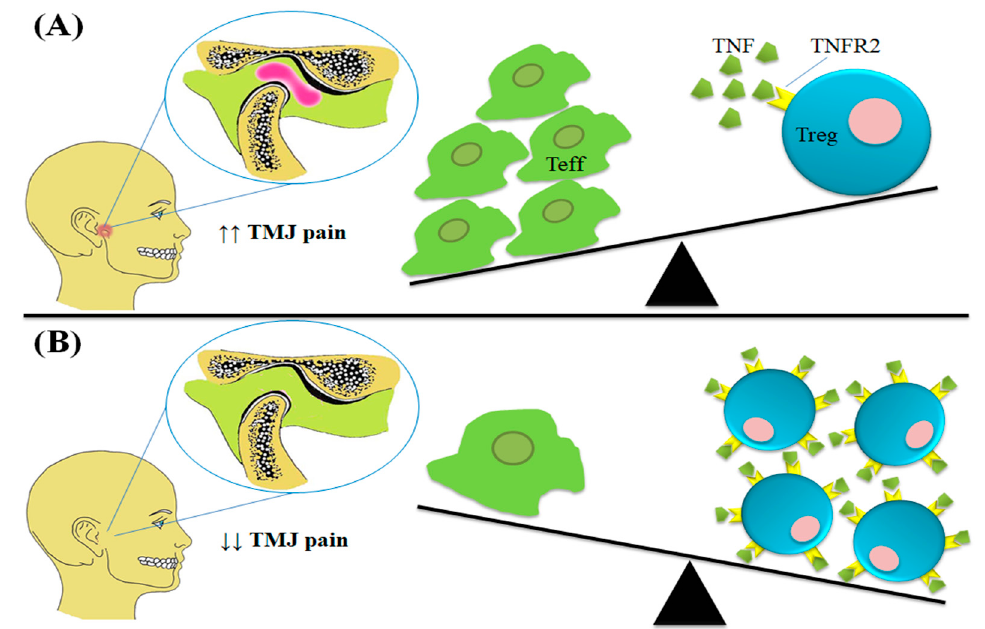
Figure 4. The hypothesized role of TNF-TNFR2 interactions in suppression the inflammatory response in TMDs (Partially adapted from Dimitroulis, 2018 [132]). ( A ) Owning to their role in suppression the immune response (i.e., Teffs), the inhibition of Tregs growth and development expected to be negatively associated with the severity of inflammation and pain in patients with TMD. ( B ) Using of TNFR2-agonists would results in upregulation of TNFR2 on Tregs, and then acceleration of cell growth, development, and extending the immune suppression effects of Tregs. Thus, the weaker inflammatory response will results in pain relief.